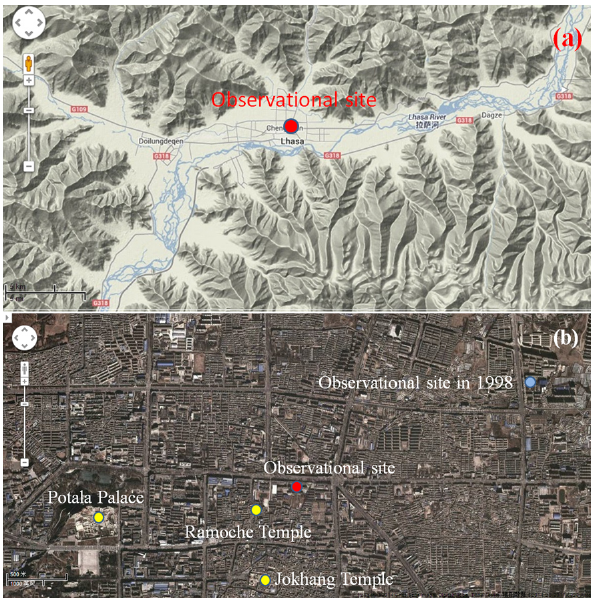
Figure 1. (a) The topography and (b) the urban map of the site and its surrounding area (from Google